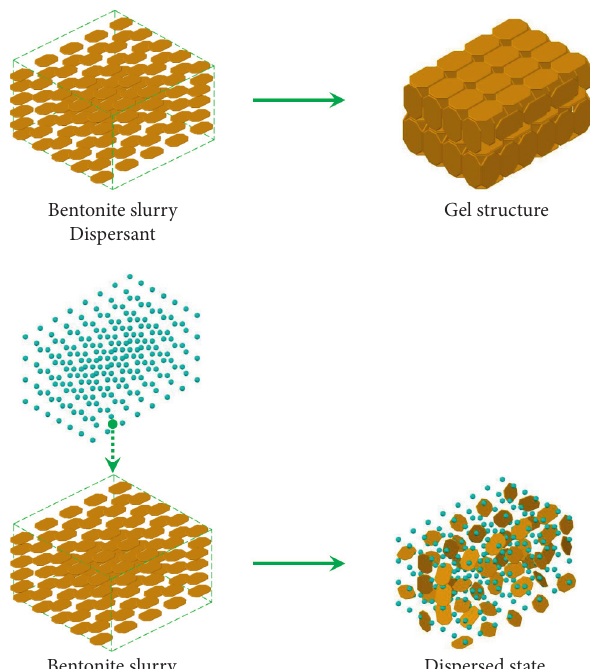
Figure 12: Dispersant mechanisms of